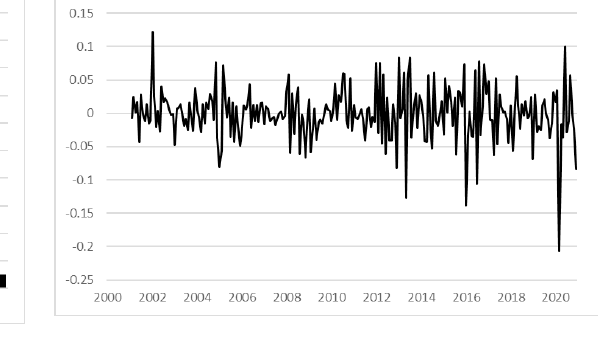
Figure A7. ACF for the turnover for wholesale Figure A8. Turnover for wholesale and retail and retail trade and repair of motor vehicles trade and repair of motor vehicles and and motorcycles in Bulgaria (logs, seasonal motorcycles in Bulgaria (logs, first, and seasonal differences)